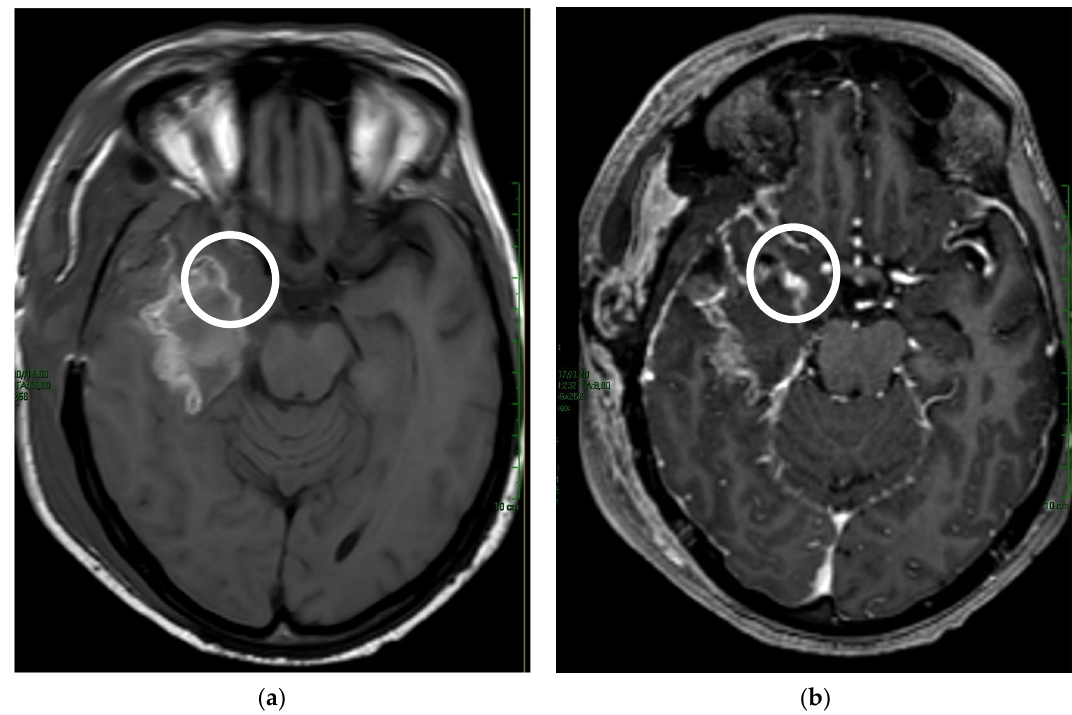
Figure 1. Comparison of ( a ) T1-weighted pre-contrast with ( b ) T1-weighted post-contrast shows the nodular impregnation of the surgical margin (white circle).